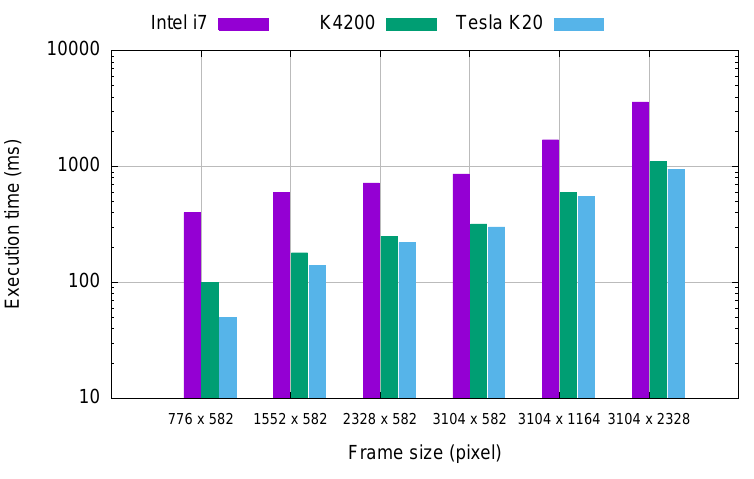
Figure 10. Comparison of the execution time of sequential and parallelized implementation of the Canny detection